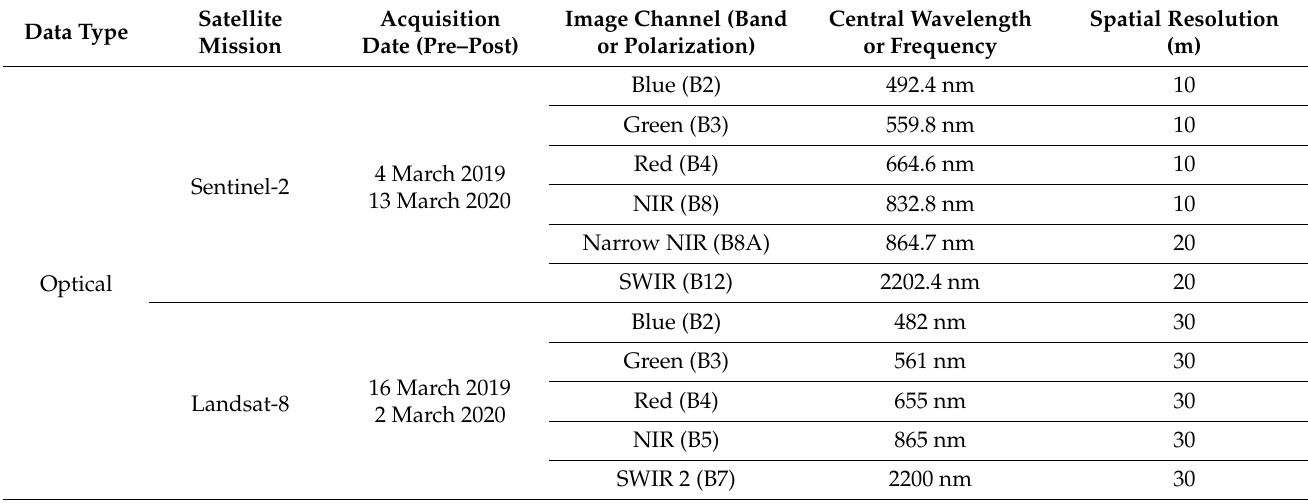
Table 1. Multi-sensor remote sensing satellite data specifications used in this study.